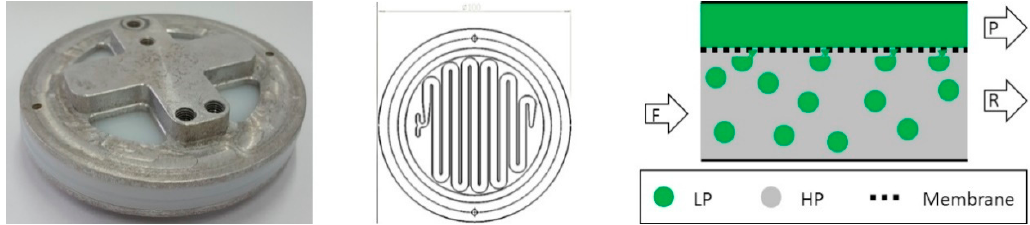
Figure 2. Miniaturized device for intensification of liquid-liquid extraction (membrane extractor). Exterior view of the device ( left ); inner channel structure ( middle ); schematic representation of the hypothesized membrane based phase separation ( right ). Feed (F), retentate (R) and permeate (P) channels are shown.